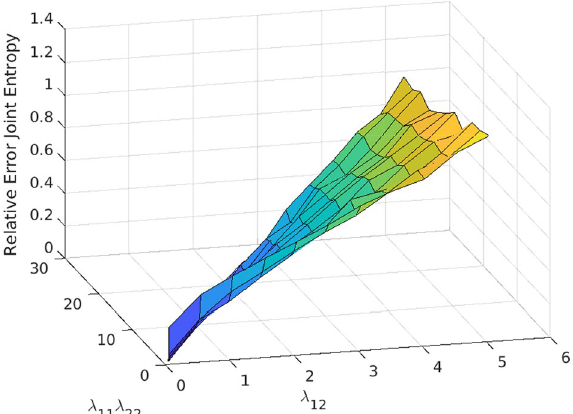
Fig. 3 The relative error in the joint entropy calculation between the joint entropy calculated through truncation and the joint entropy calculated by our approximation. It is clear that when both (cid:31) 12 and (cid:31) 11 (cid:31) 22 are small, the relative error is small. Thus we expect this approximation to work well when all of the estimated rates are small. In practice we find that when scaling the rates to be in [0, 1] we get good results, regardless of how high the true rates